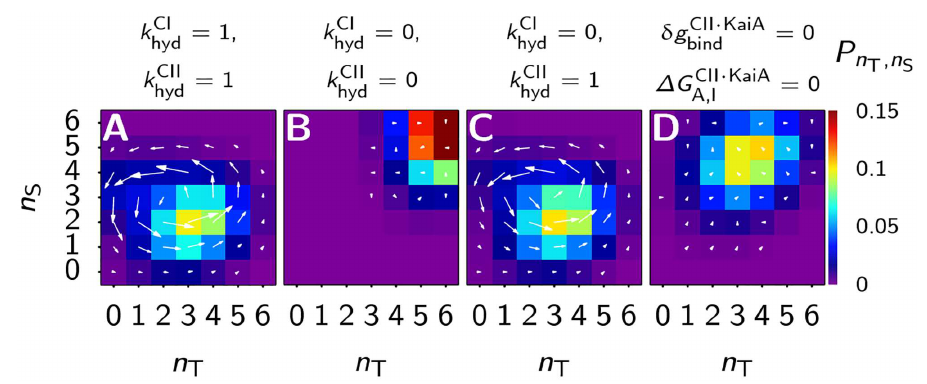
Fig 8. Hydrolysis in the CII domain, without KaiA sequestration by the CI domain, is sufficient to generate the ordered phosphorylation of the T and S sites in a solution of KaiC and KaiA. In all panels, the bulk ATP fraction is 50%. (A-D) Heatmapsof the probability, P , for a single hexamer, of having n T n T ; n S phosphorylated threoninesites and n S phosphorylated serinesites. Arrows indicatethe net flux through a state, where the length is proportional to the magnitudeof the flux. (A) KaiC and KaiA, with hydrolysisof ATP in both the CI and CII domains,shows a clear orderedcycle in state space. (B) Without hydrolysisin both the CI and CII domains,all the equationsin our model obey detailed balance, and the fluxes in state space disappear. (C) When we remove hydrolysisin the CI domain,the fluxes in phosphorylationstate space are little affected comparedto panel A. (D) When there is hydrolysisin both domains,but no differentialaffinity of the CII domainfor KaiA, the hydrolysiscycle in the CII domaindoes not coupleto the phosphorylation cycle, and there is no ordered phosphorylation.